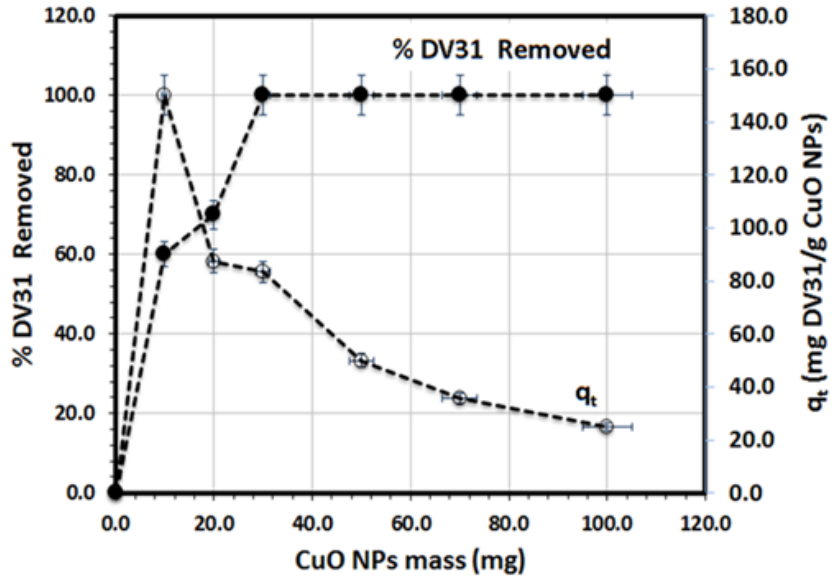
Figure 6. Effect of CuO NPs mass for the removal of DV31 dye from aqueous solution. (Experimental conditions: DV31 dye concentration 25 mg/L; sample volume 100 mL; 30 min contact time; 0.5 mL H 2 O 2 ; pH 8.6 and temperature at 25 °C).